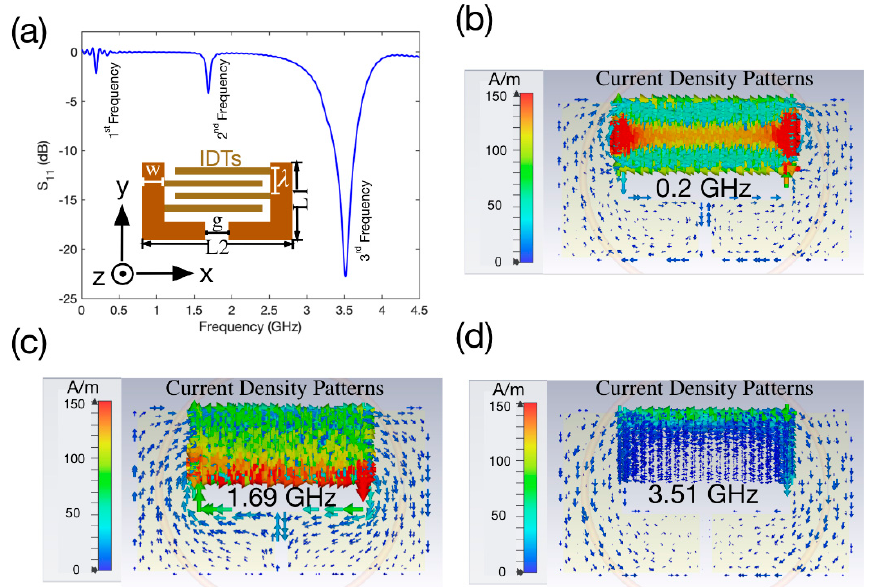
Figure 1. Simulation results of the fabricated device. ( a ) Reflection Coefficient, S 11 , within the range of 0–4.5 GHz. ( b – d ) current density patterns at 0.2, 1.69, 3.51 GHz respectively.